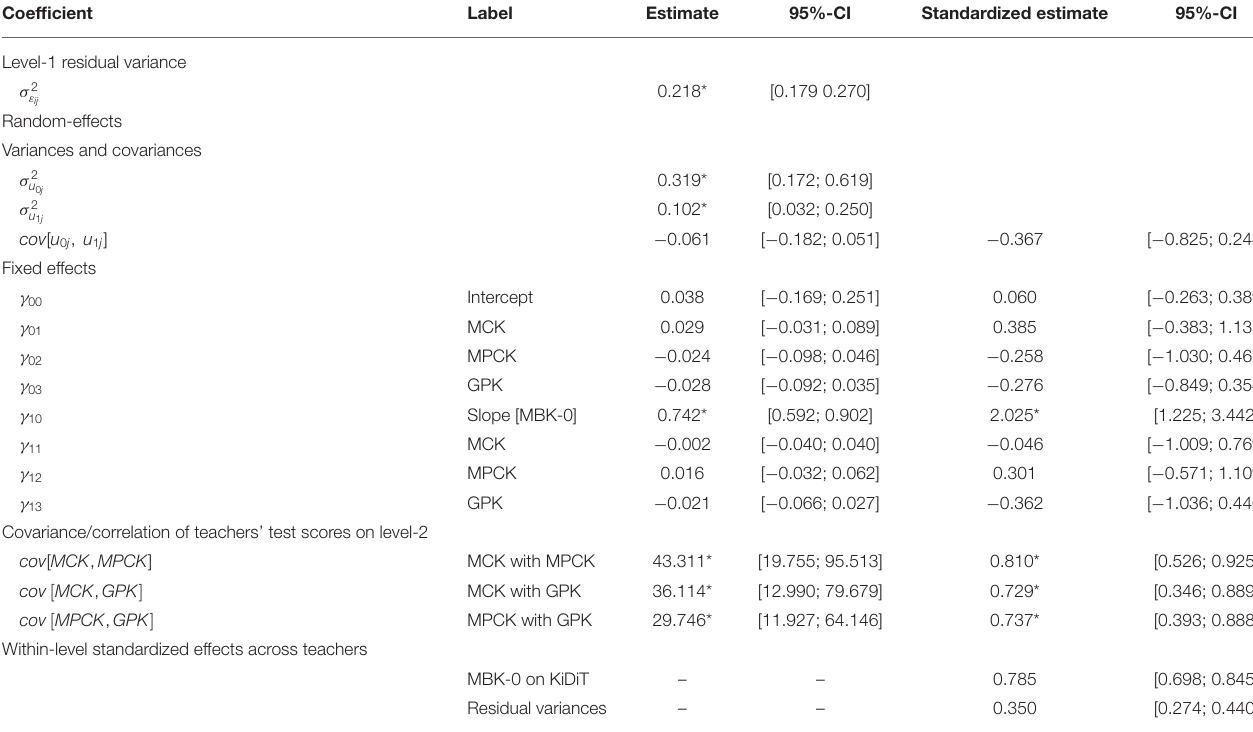
TABLE 2 | Model 2: Predicting the random intercepts (absolute judgment accuracy, level component) and random slopes (relative judgment accuracy, rank component) by test scores of